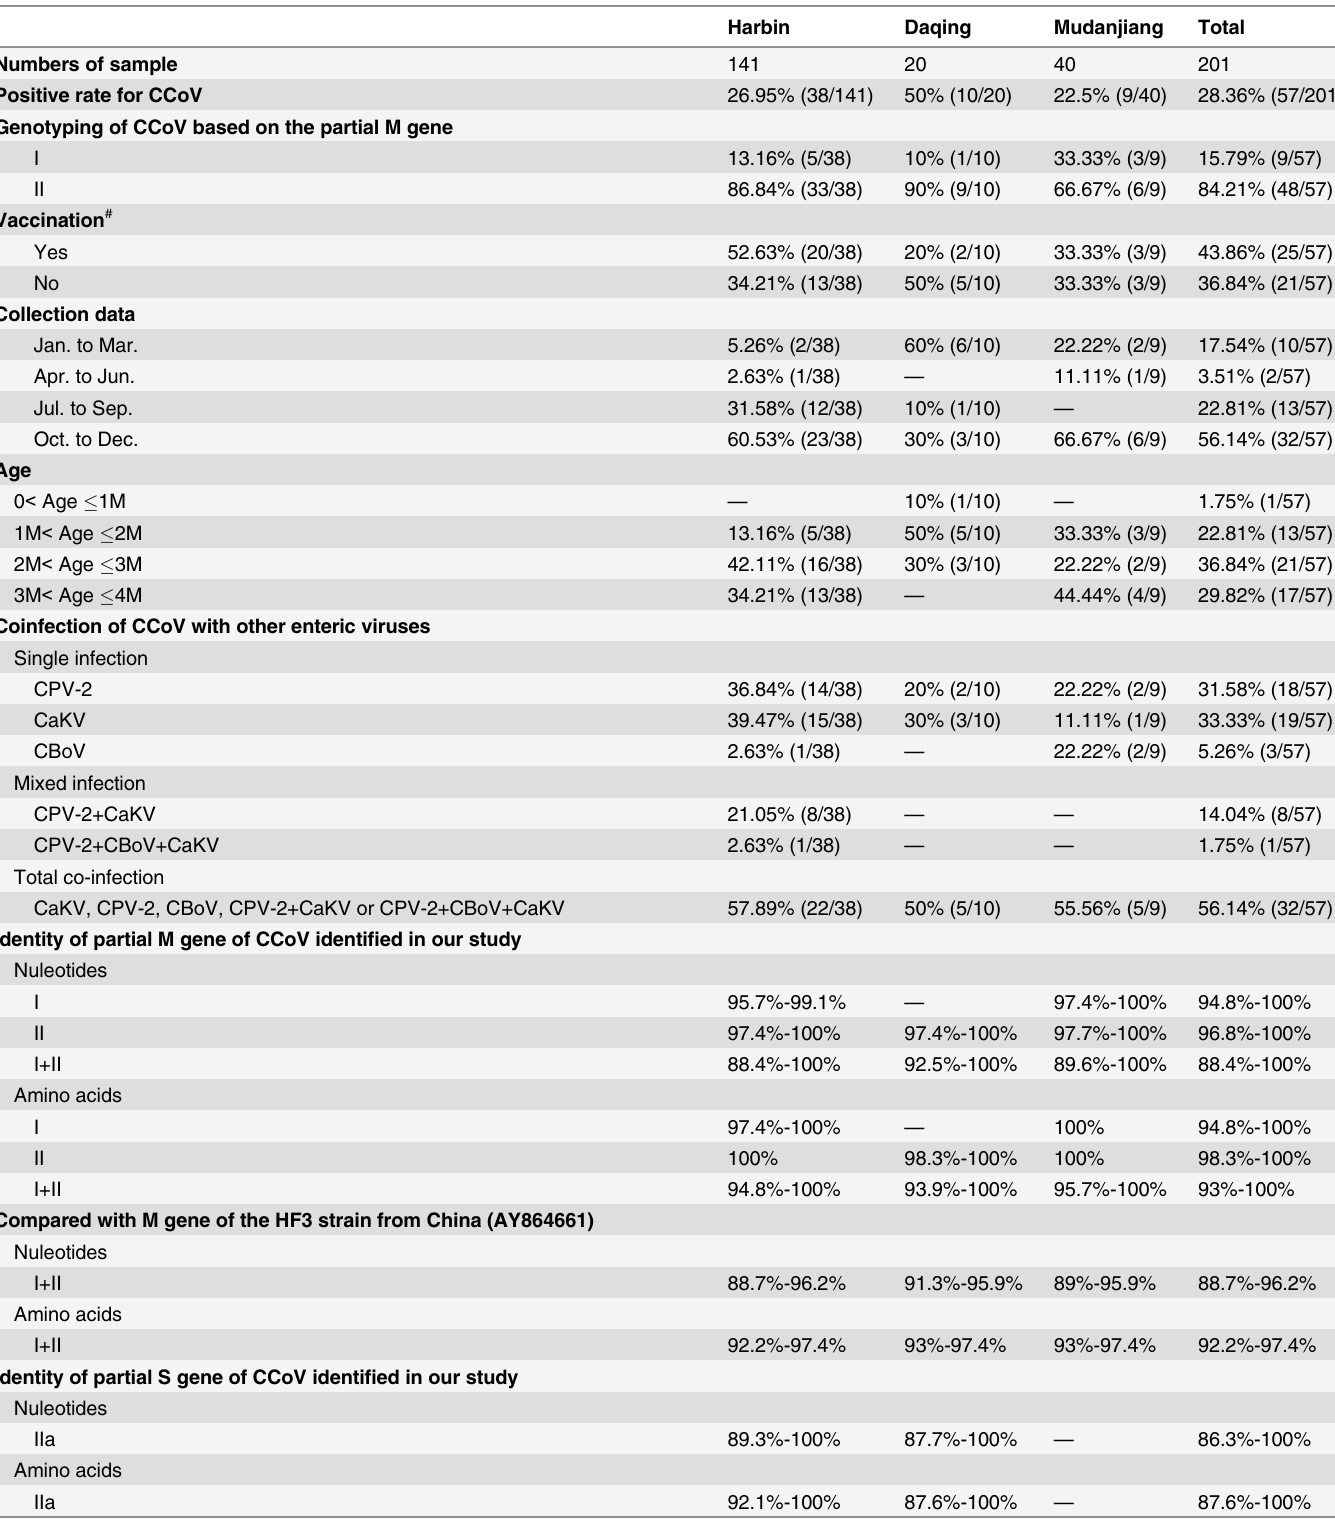
Table 1. Further analysis of the CCoV-positive